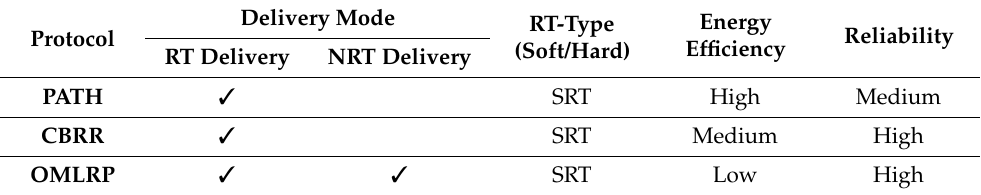
Table 3 establishes a comparison between delivery mode-based routing protocols [52]. Table 3. Delivery mode-based routing protocols for WSNs.